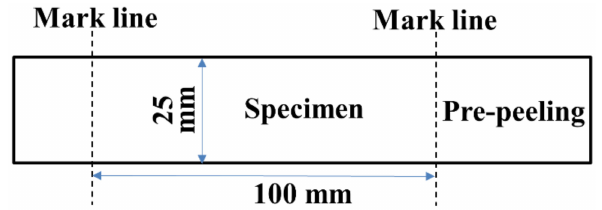
Figure 4. Specimen for peeling strength.